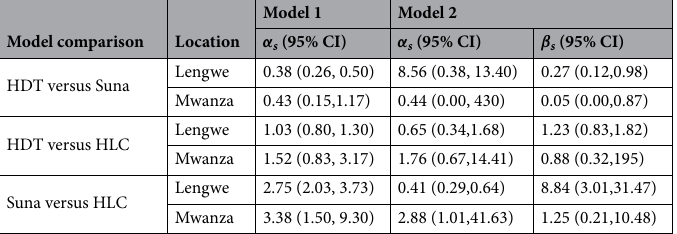
Table 2. Summary of the model parameter estimates for each trapping